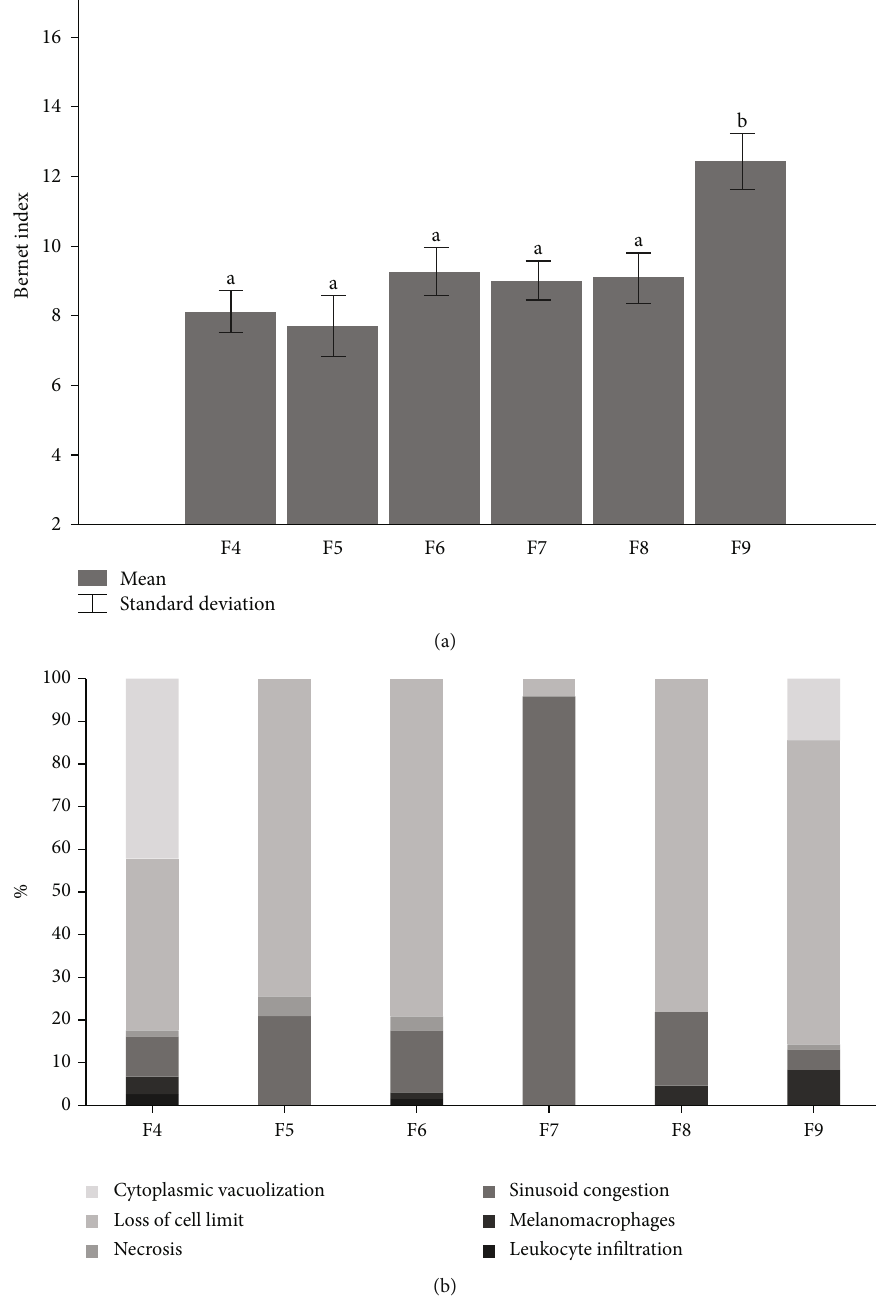
Figure 2: Bernet index (a) and index of histopathological lesions (b) of Nile tilapia fi ngerlings ( Oreochromis niloticus ) fed on F4 diets: fed 4 times a day; F5: fed 5 times a day; F6: fed 6 times a day; F7: fed 7 times a day; F8: fed 8 times a day; and F9: fed 9 times a